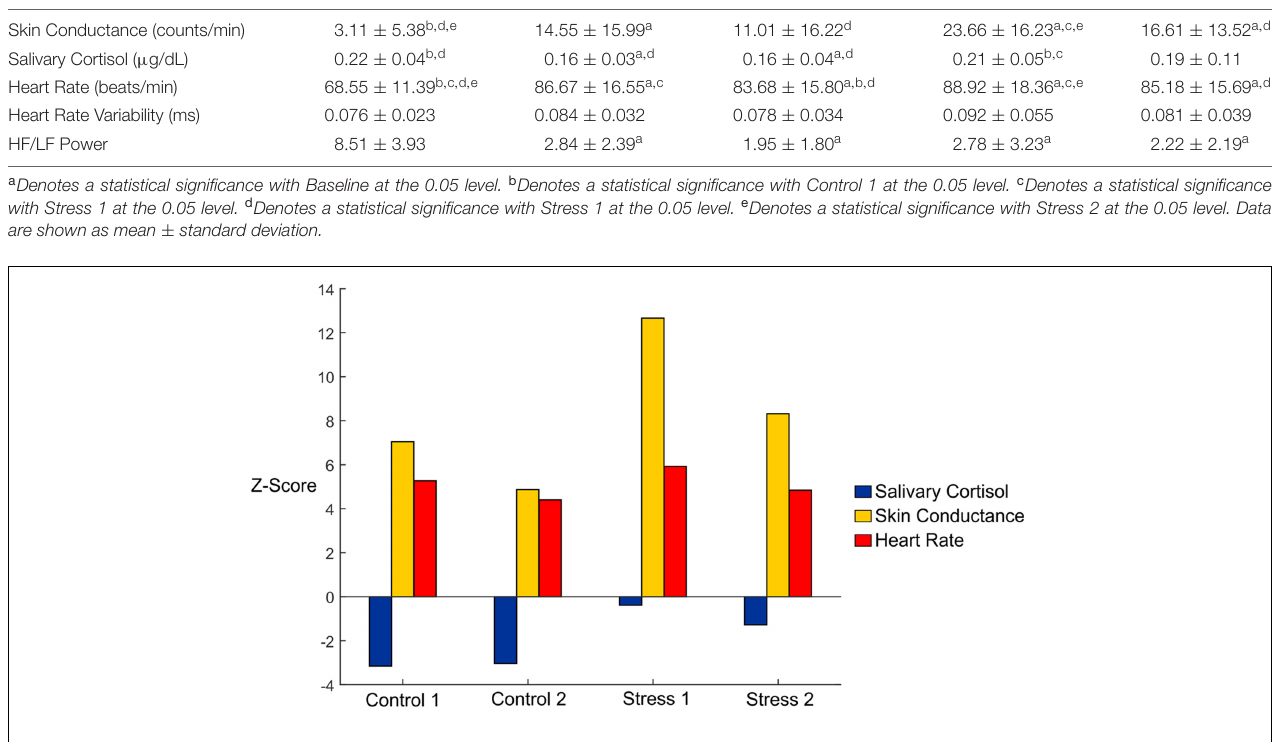
FIGURE 2 | Z -scores of salivary cortisol (blue), skin conductance (gold), and heart rate (red) data in each of the experimental conditions. Data are shown with mean baseline values subtracted for each variable, and the Z -scores were calculated using the standard error for each